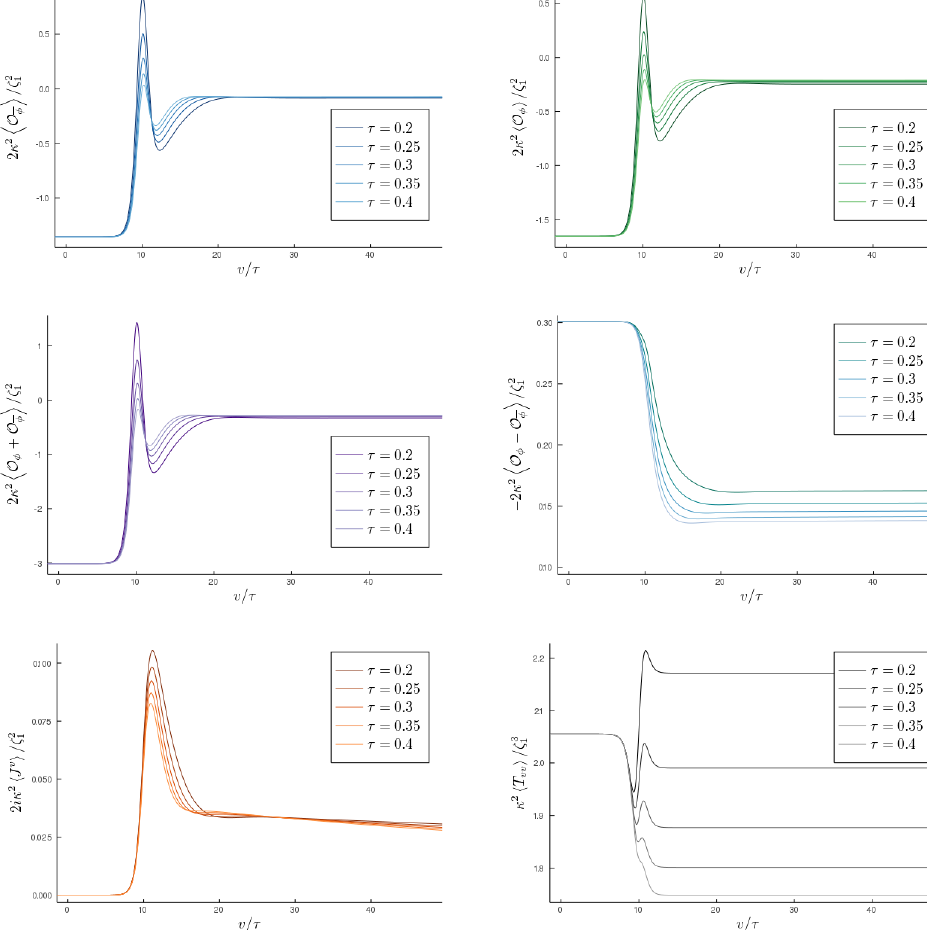
Figure 7: Expectation values 2.22 for a quench with parametrisation 3.4 of the boundary values of the fields with profile 3.1 for χ and for several values of τ la- belling different curves. We interpolate between χ /τ = v m